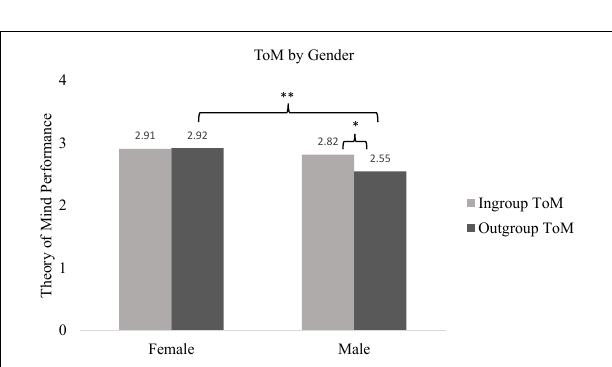
FIGURE 2 | Participants’ ingroup and outgroup ToM by gender. ∗ p < 0.05, ∗∗ p < 0.01.